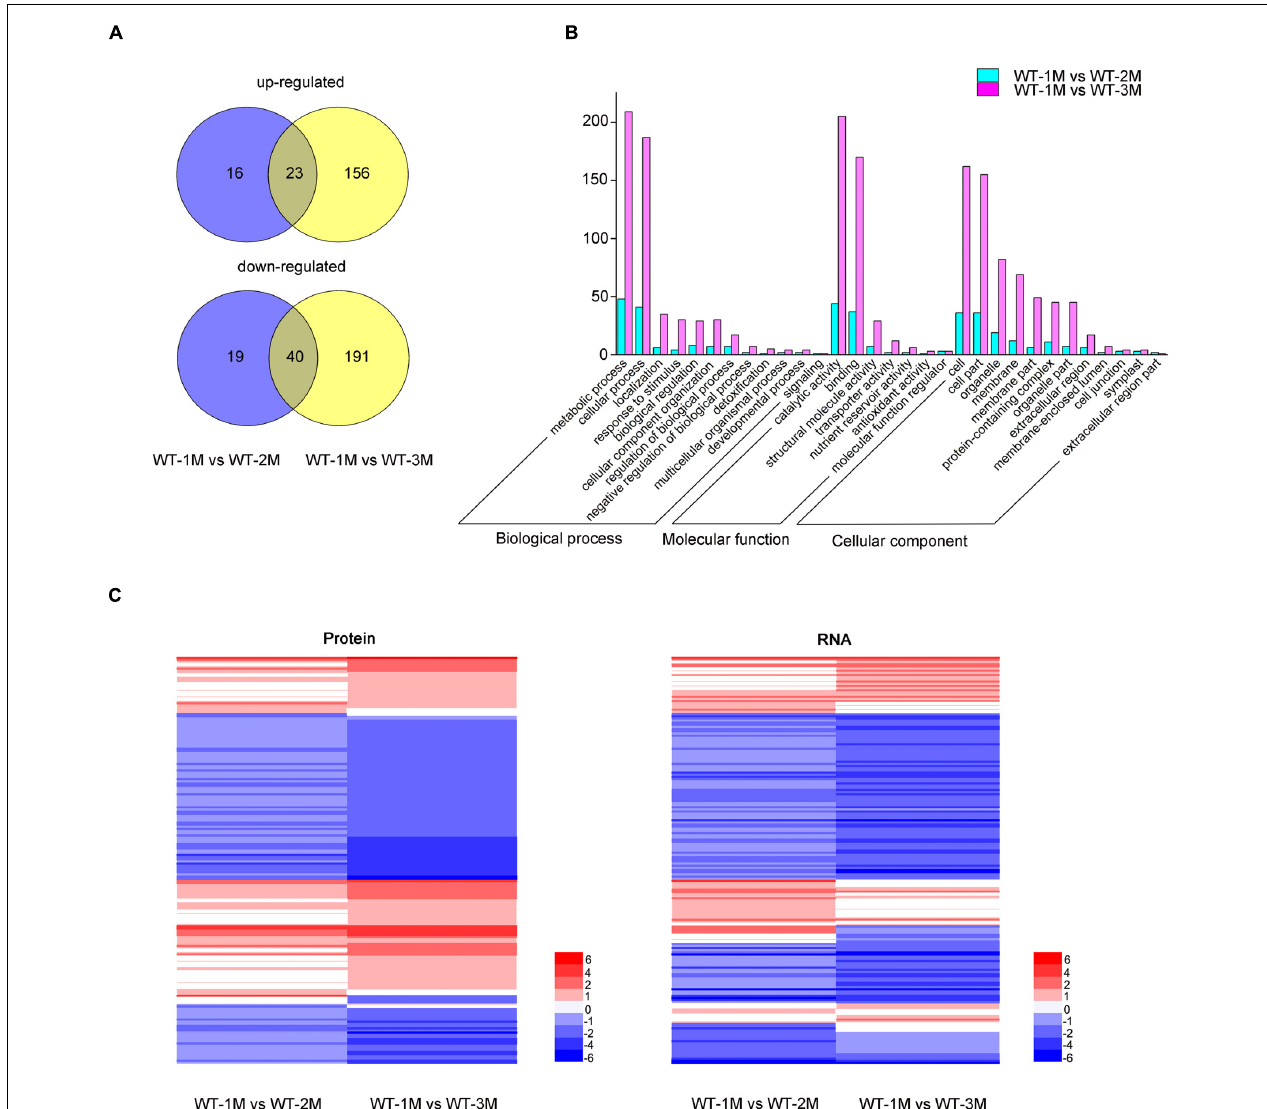
FIGURE 6 | Proteomic analysis of differentially expressed proteins involved in xylem development in P. tomentosa . (A) Numbers of upregulated and downregulated proteins in WT-1M vs. WT-2M and WT-1M vs. WT-3M. P < 0.05, fold change ≥ 2 or ≤ –0.5. (B) Numbers of differentially expressed proteins of “Biological process,” “Cellular component,” and “Molecular function” in different functional categories in WT-1M vs. WT-2M and WT-1M vs. WT-3M. (C) Hierarchical cluster analysis of differentially expressed proteins of WT at three different months. The color scale bar on the right indicates the expression proteins and mRNA level. The values given in the legend are log2 (fold